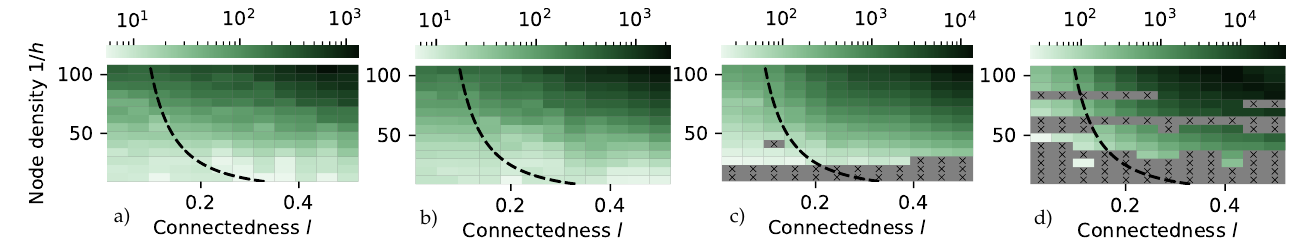
Figure 7. Runtime of the DisCOptER algorithm in seconds. Top right corner: dense graph. Bottom left corner: sparse graph. Gray areas: not converged or converged to local minimum. Black dashed line: h = l 2 . Subfigures refer to the corresponding test problems.